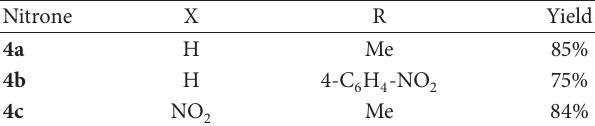
Table 1: Yields of nitrones 4a – c